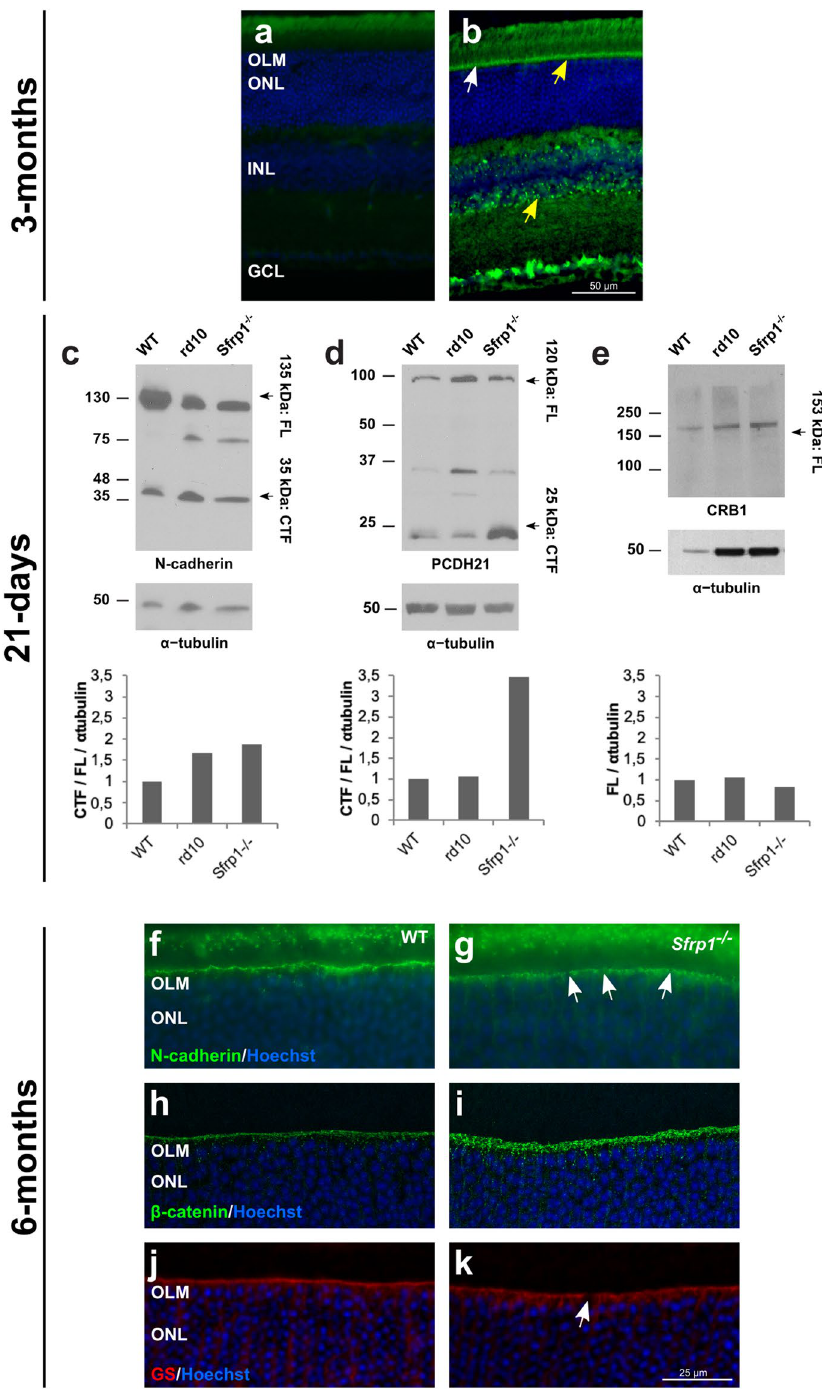
Figure 5. Proteolysis of OLM and OS proteins is increased in Sfrp1 − / − retinas leading to an abnormal protein distribution. a, b) Frontal cryostat sections from 3 months-old wt retinas immunostained with secondary antibodies only ( a ) or with anti-ADAM10 ( b ). Sections are counterstained with Hoechst. Note the specific immune signal in the OLM (arrows) and in the INL where Müller glial cells are located (yellow arrows). ( c–e ) Western blot analysis of N-cadherin, PCDH21 and CRB1 content in total protein extracts from three weeks-old wt, Sfrp1 − / − and rd10 retinas, as indicated in the panels. For N-cadherin and PCDH21, membranes were probed with antibodies recognizing the respective C-terminal fragments (CTF). Graphs at the bottom of each panel indicate the rate of CTF proteolysis for N-cadherin ( c ) and PCDH21 ( d ), calculated as CTF/FL, or the CRB1 levels ( e ). Plotted values are normalized to α -tubulin. ( f – k ) Frontal cryostat sections from 6 months-old wt and Sfrp1 − / − retinas immunostained with antibodies against N-cadherin, β -catenin, and GS as indicated in the panels. Sections are counterstained with Hoechst. White arrows in g, k indicate the gaps in the OLM. Scale bar calibration in k applies to all panels. Abbreviations: CTF: C-terminal fragment; FL: full length; OLM: outer limiting membrane; ONL: outer nuclear